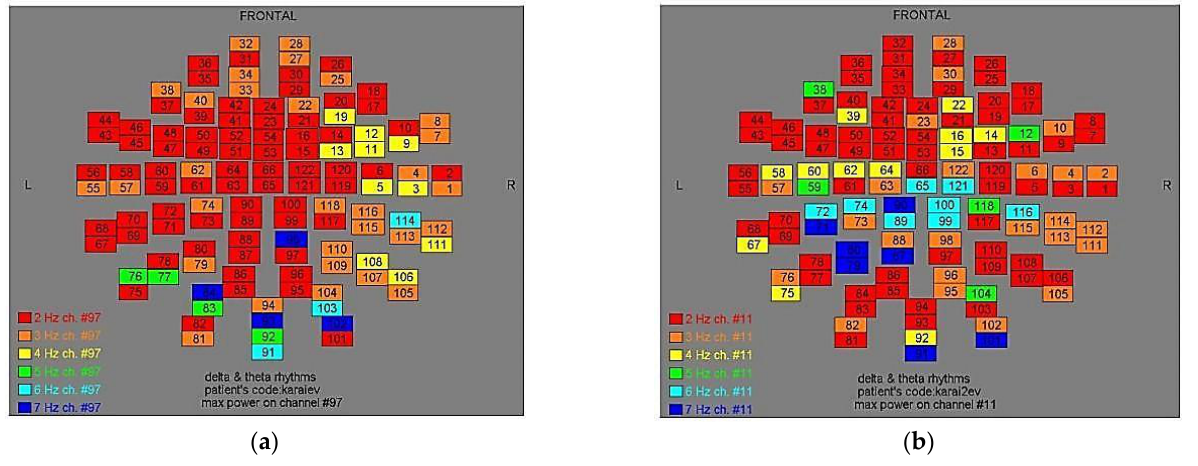
( b ) Figure 8. Dominant frequency color mapping for patient #7, before ( a ) and after ( b ) magnetic stimulation .